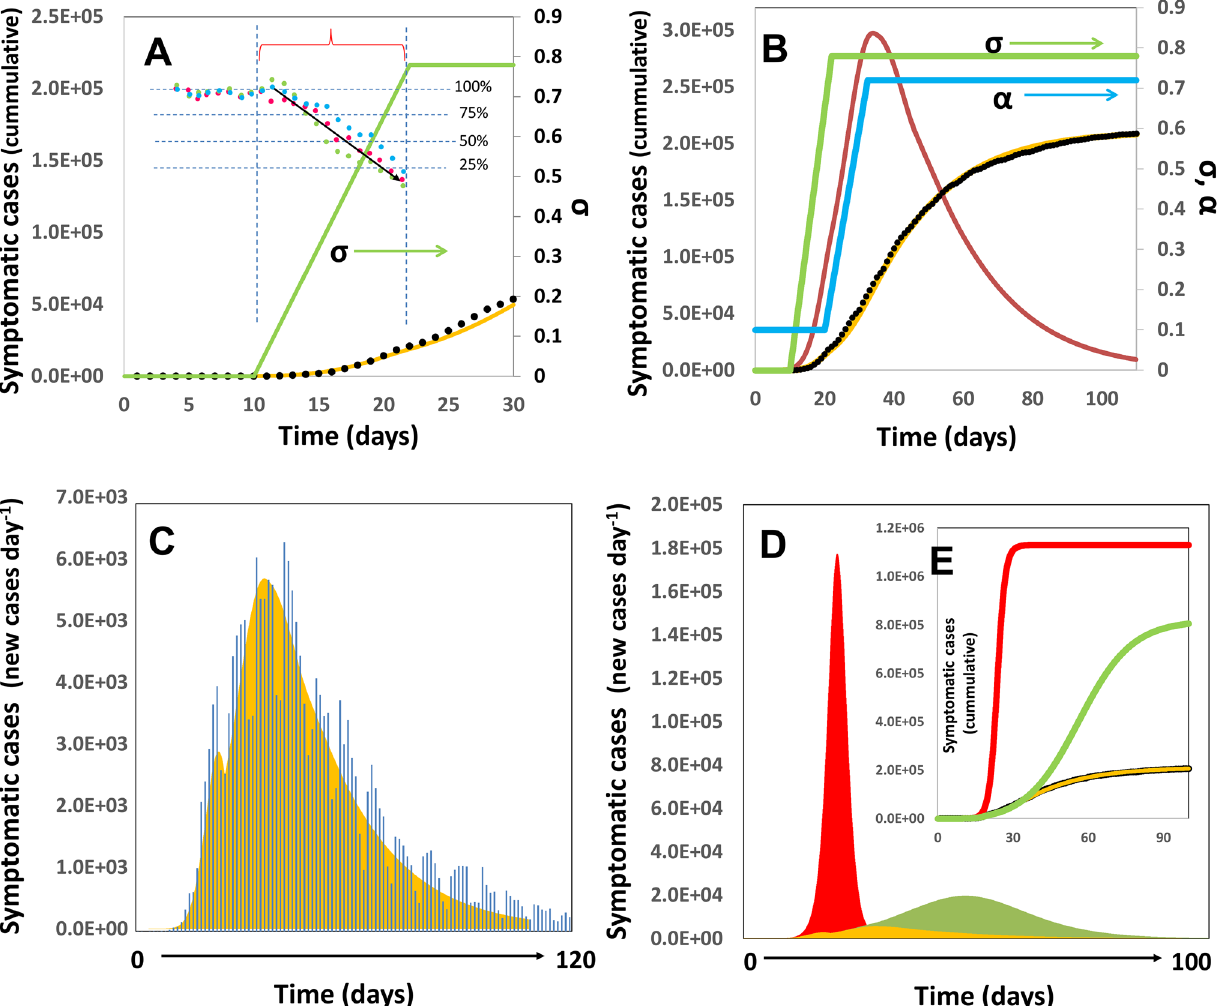
Figure 3. Progression of the COVID-19 Pandemic in NYC. ( A ) Initial evolution of the number of positive cases of COVID-19 in NYC. Actual data points, as officially reported, are shown using black circles. Simulation predictions are described by the yellow line. The profile of social distancing values used in simulations (σ) is shown as a green line. Relative change in visits to different type of places in NYC as reported by Bakker et al. (modified from Ref. 46 ): food (green circles), shopping (red circules), and city/outdoors (blue circles) ( B ) Model prediction of the total number of symptomatic patients through the months of March and May. Actual data points, as officially reported, are shown using black circles. Simulation predictions are described by the yellow line. The profiles of social distancing (σ) and testing effort (α) are shown as green and blue lines, respectively. The value of (X–R), determinant of the progression of the infection among population, is shown as a red line. ( C ) Model prediction (yellow) and actual number of new cases of COVID-19 per day (as reported by the NYC authorities; blue bars; https ://www1.nyc.gov/site/doh/covid /covid -19-data.page) during the period from March 1 to June 30, 2020. ( D ) Prediction of the number of new cases of COVID-19 per day if no containment actions were adopted (red area), if only social distancing were adopted (in accordance with the green profile of σ values in A and B) (green area), or in the actual case were social distancing combined with intensified testing and quarantine were adopted (yellow area). The inset show the cumulative number of cases predicted by the model for the same scenarios previously described. Actual data points corresponding to the officially reported number of cumulative COVID-19 cases in NYC are shown as black distancing [σ ~ 0.75; α = 0.10], and with social distancing and aggressive testing as actually implemented). Note that in the context of our work, no intervention implies that persons diagnosed as positive for COVID-19 are still quarantined (α = 0.10). Our simulations predict that the total number of cases positive for COVID-19 would have exceeded 1.3 million in the absence of social distancing measures during the first 100 days of the epidemic. The implementation of social distancing alone would have resulted in nearly 800,000 positive cases within the same timeframe. The combination of social distancing and aggressive testing decreased this sum to nearly 200,000 and avoided a human catastrophe in one of the most densely populated cities in the world. We also explored the adequacy of our demographic model for describing the dynamics of the first pandemic wave in South Korea. South Korea based its strategy of COVID-19 control on widespread testing, efficient